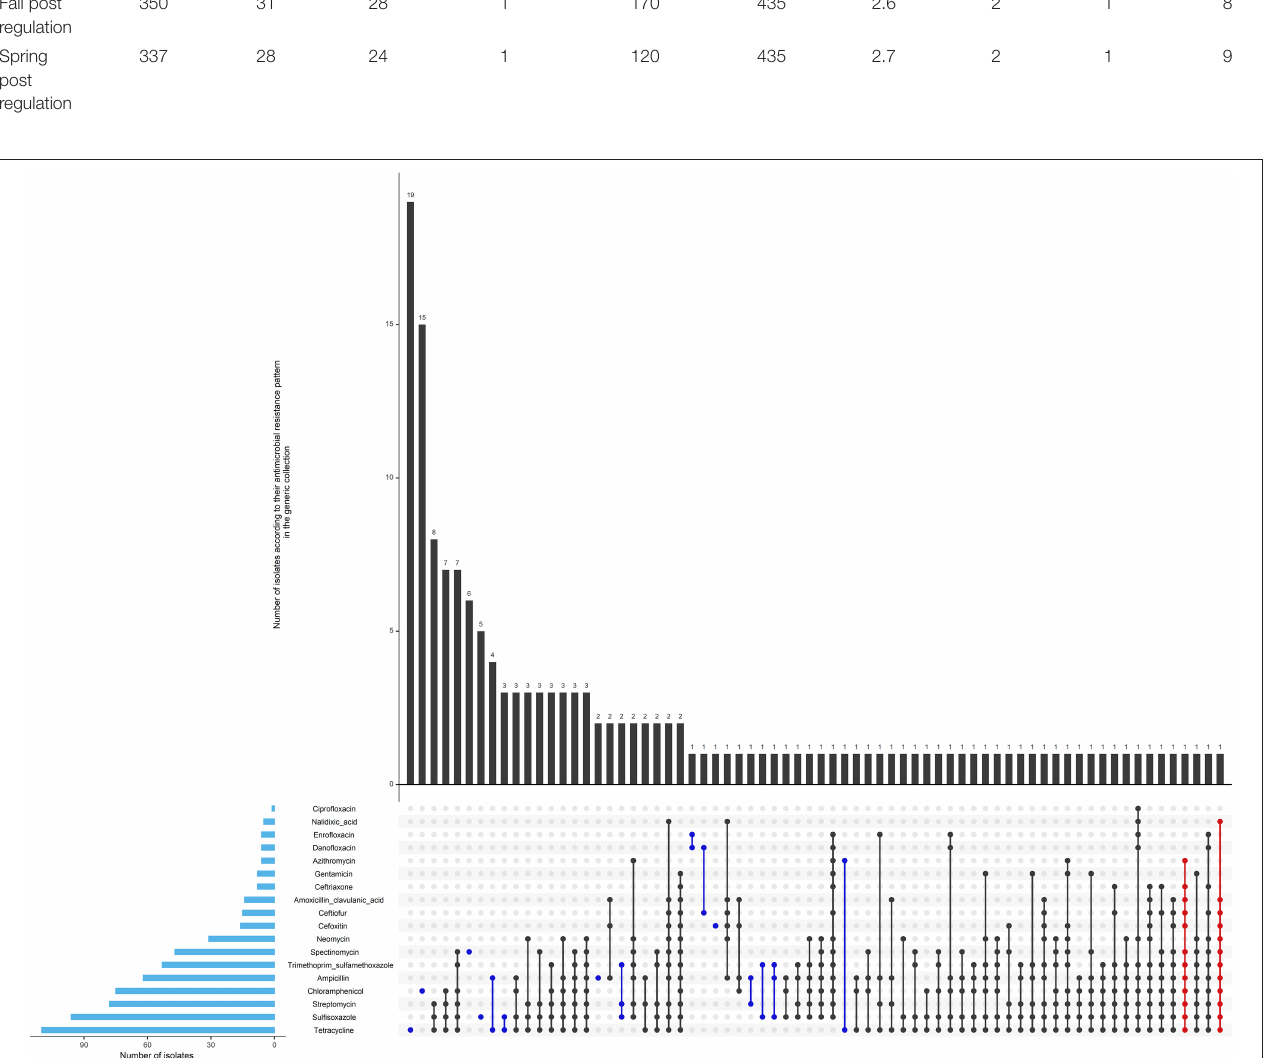
FIGURE 2 | Antimicrobial resistance pattern of 509 isolates of the generic collection from calf, cow feces or manure pit of 87 dairy farms in Québec, Canada in 2020–2021. The horizontal blue bars represent the frequency of isolates resistant to each antimicrobial. An antimicrobial pattern is represented by the linked dots. Black dots represent the MDR patterns, and red dots represent the XDR patterns. The vertical bars represent the frequency of isolates for each antimicrobial pattern. 352 (69%) isolates were susceptible to all antimicrobials (not represented in the figure).